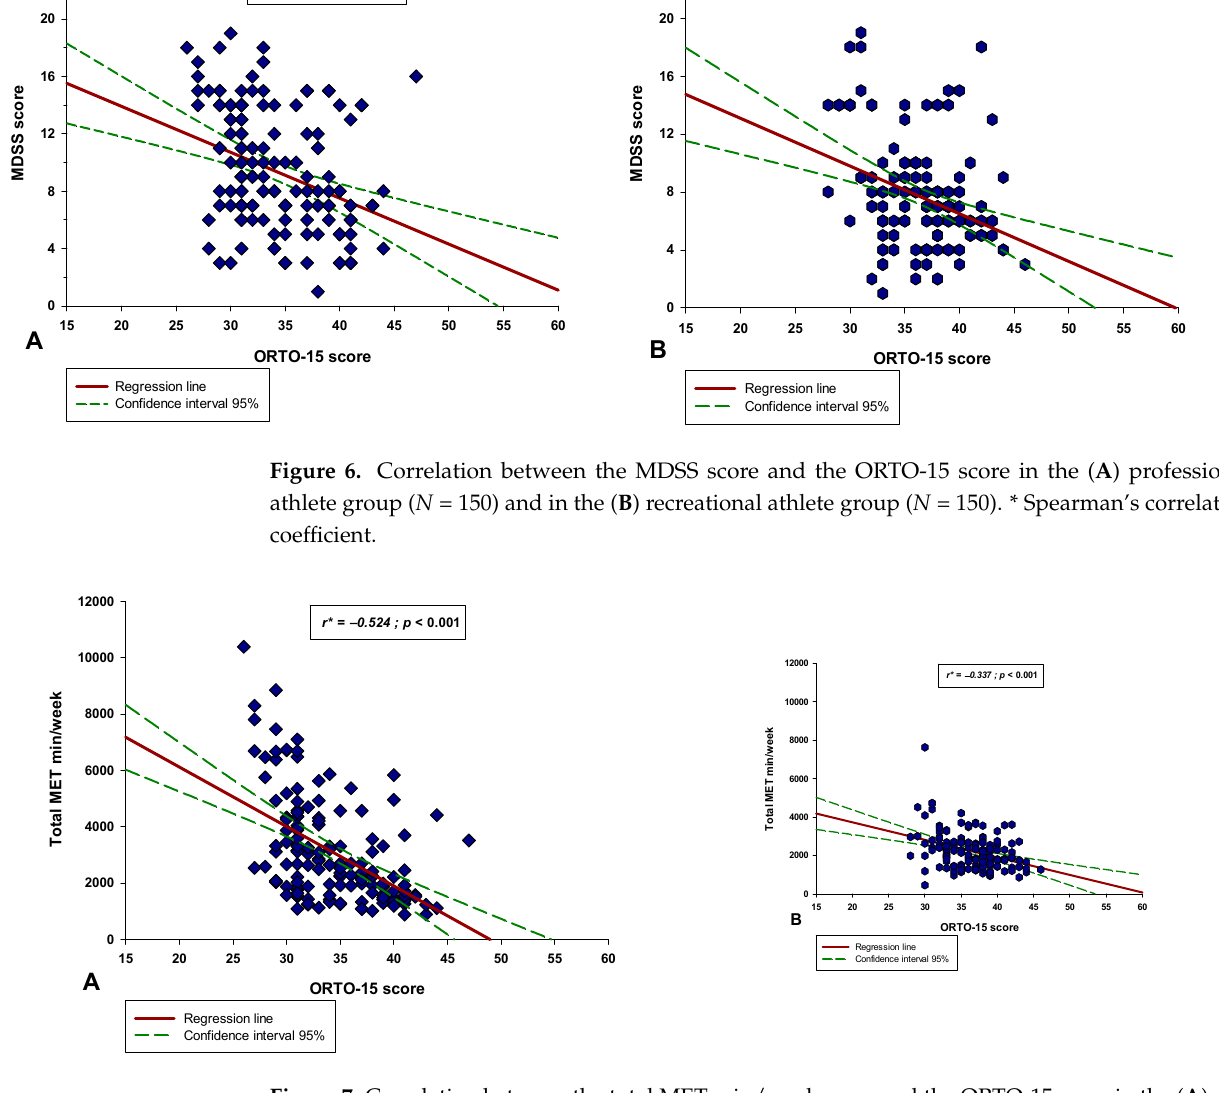
Figure 7. Correlation between the total MET min/week score and the ORTO-15 score in the ( A ) professional athlete group ( N = 150) and in the ( B ) recreational athlete group ( N = 150). * Spearman’s correlation coefficient.